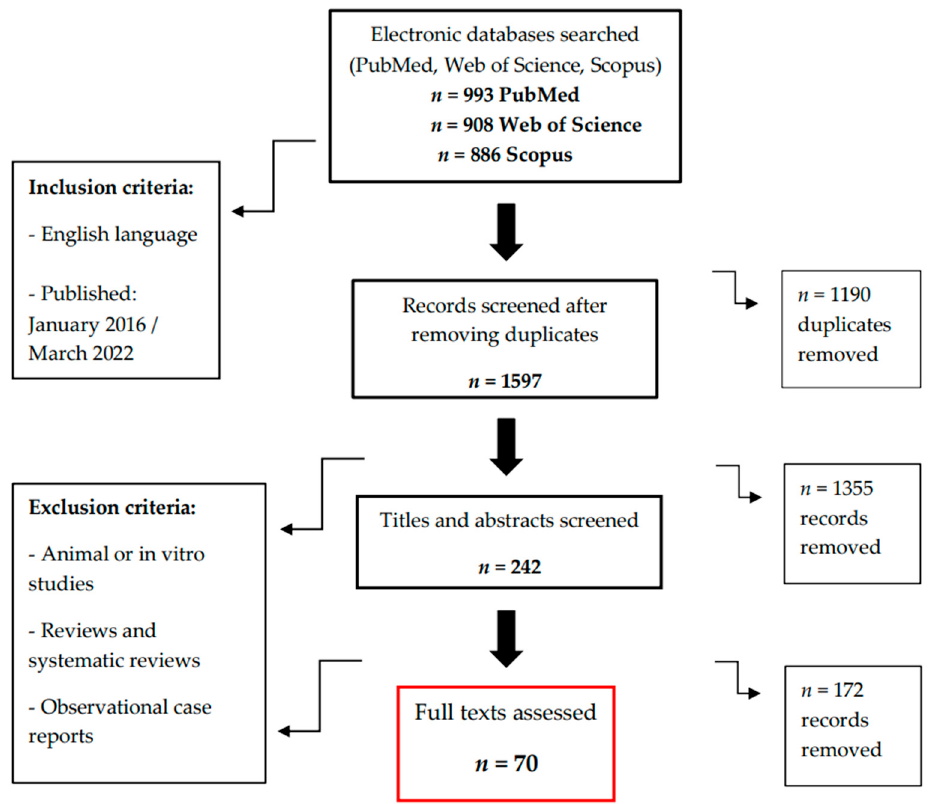
Figure 1. Flowchart of the decision-making process for the selection of the articles eligible for re- view .